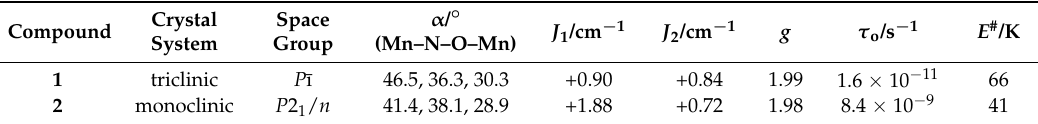
Table 2. Selected magneto-structural parameters for compounds 1 and 2 .